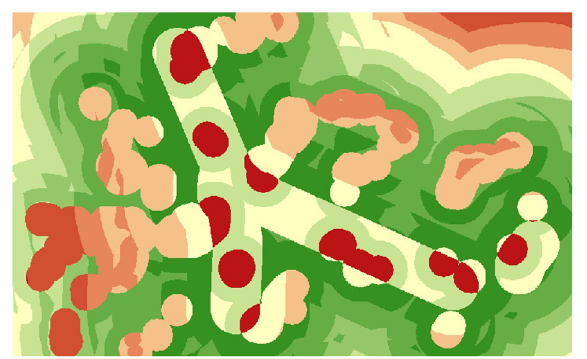
Figure 13. Weighted overlay.